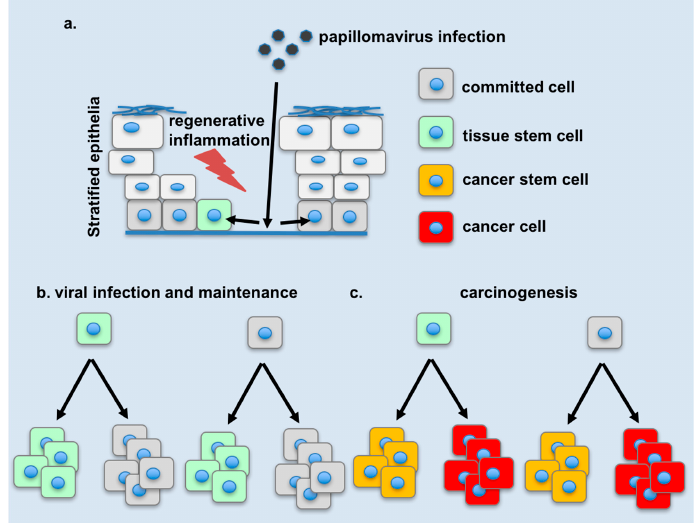
Figure 2. Model of changes in stem cells during papillomavirus infection and carcinogenesis. ( a ) Papillomaviruses can gain access to the basal layer of stratified epithelia via microwounds. Following attachment to the basement membrane, the virus can infect committed or stem cells in the basal layer of the epithelium. As the epithelium heals, infected cells are subject to changes due to the expression of early gene products and local inflammatory signals linked to infection and the regenerative response. ( b ) Stem cells or stem-like cells (with at least some atypical features) detected during infection and viral maintenance may be derived from infected stem cells or committed cells which have been reprogrammed. ( c ) Cancer stem cells may likewise be derived from infected tissue stem cells or from drastically de-differentiated committed